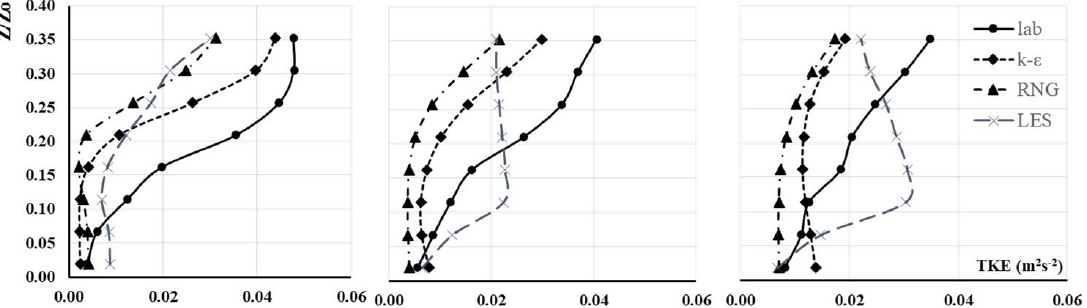
Figure 16. Comparison of measured and computed TKE (m 2 s − 2 ) profiles in the experimental zone (dim in meters) for ( A ) 2.45 m; ( B ) 2.50 m and ( C ) 2.55 m from